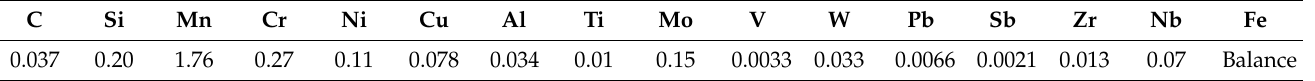
Table 1. The chemical composition of X80 pipeline steel (wt%).